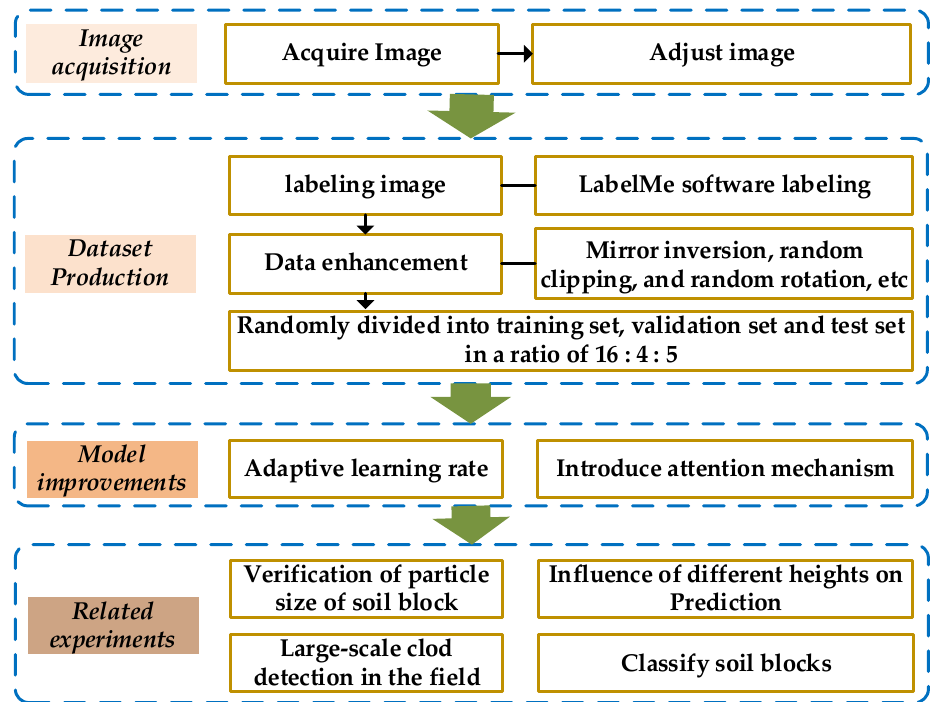
Figure 2. Flow chart of the method.